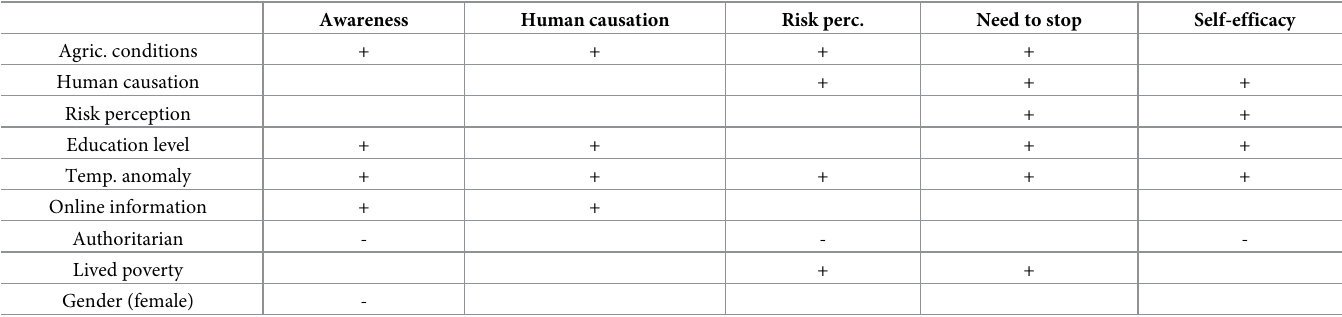
Table 1. Direction of relation of key predictors to